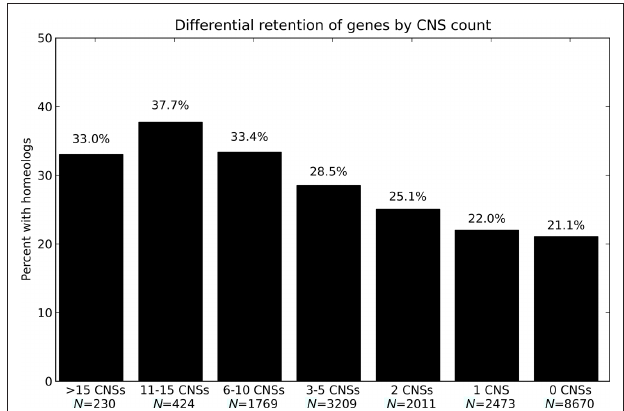
Figure 3 | Odds of possessing a retained homeolog for genes with different numbers of associated CNSs. Odds of possessing a retained homeologous gene from the pregrass whole genome duplication for genes with different numbers of associated